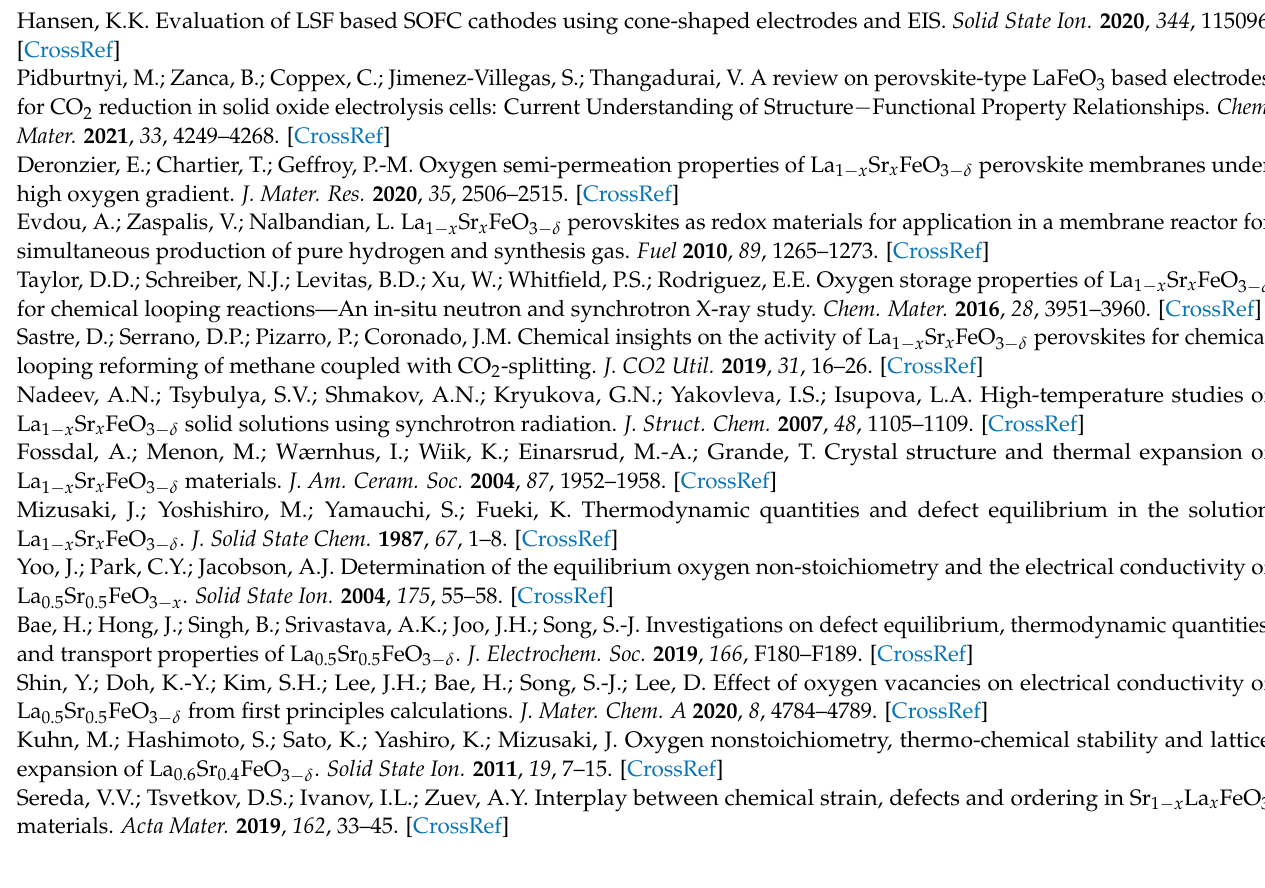
Table S1: Parameters of electrical conductivity in La0.5 − xSr0.5FeO3 − δ , obtained by approximation of Eq. (1) to experimental data in vicinity of minima, Figure S2: Van’t Hoff’s plots of Kox and Kd. The solid lines represent linear approximations, Table S2: Model parameters, obtained by approximation to electrical conductivity of La 0.5 − x Sr 0.5 FeO 3 − δ . Figure S3: Arrhenius plots for mobility of n- and p-type carriers and that of oxygen ions in La 0.5 − x Sr 0.5 FeO 3 − δ